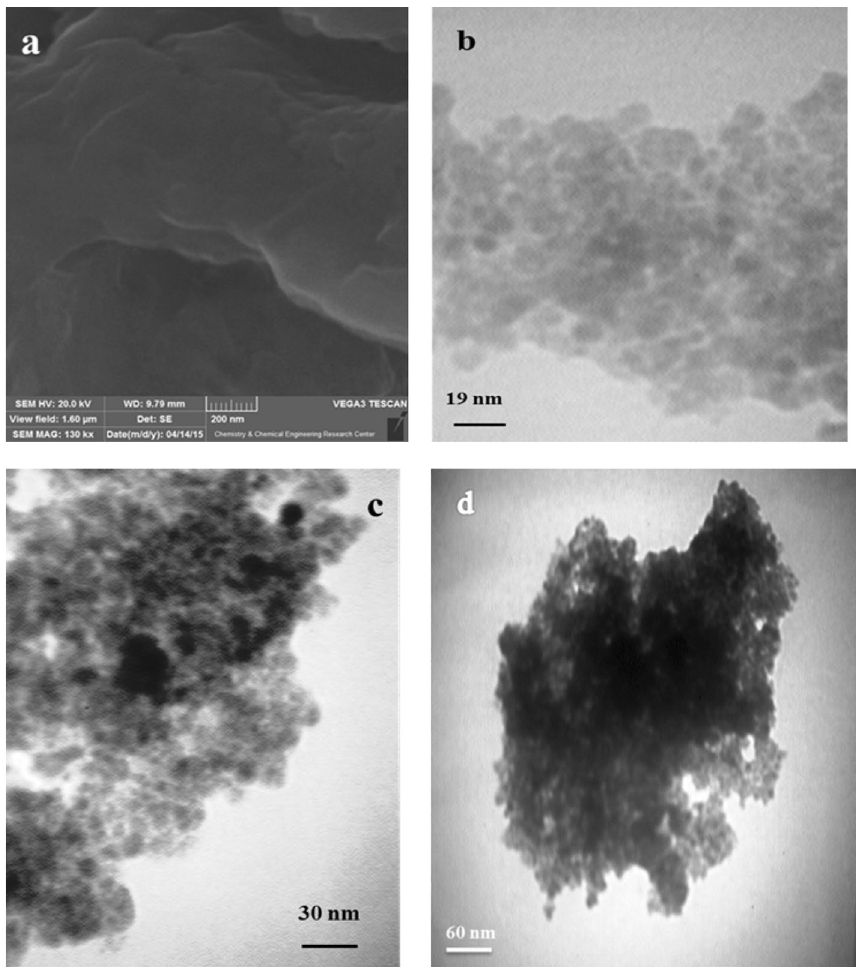
Figure 2. ( a ) SEM GO and TEM figures of ( b ) GF, ( c ) GFL and ( d )